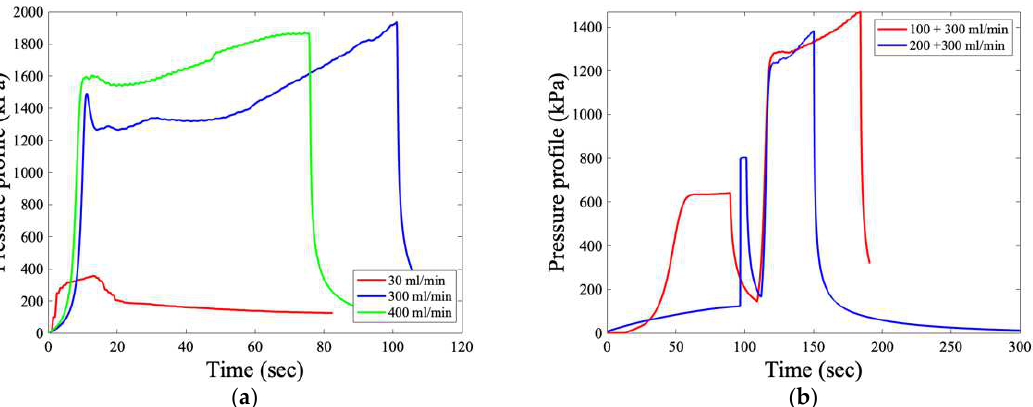
Figure 10. The pressure profiles obtained during glycerine injection experiments ( a ) for specimens at 30, 300, and 400 mL/min and ( b ) for combinations of flow rates at 100 and 300 mL/min and 200 and 300 mL/min.